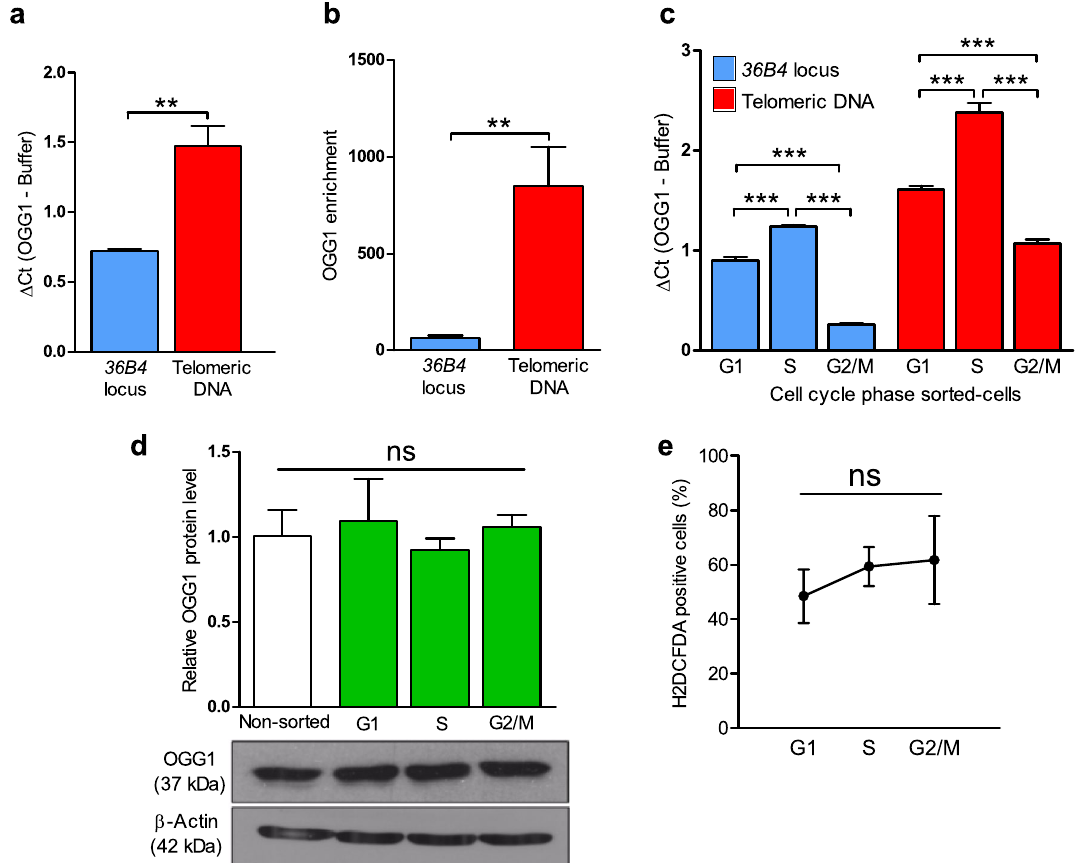
Figure 1. Telomeres are a hotspot for oxidation due to cell cycle ROS production. ( A ) DNA from U2OS cells was used to measure 8-oxoG levels at the 36B4 locus or telomeric DNA. Bars show the mean and the standard error of the mean (SEM) from 3 technical replicates from 6 independent experiments for each condition (Mann–Whitney test; **P < 0.01). ( B ) OGG1-GFP pulldown followed by chromatin immunoprecipitation coupled to PCR for amplification of either 36B4 locus or the telomere regions in the U2OS parental and U2OS OGG1-GFP cell lines. Data are the average of 3 technical replicates from 2 independent experiments. Statistical significance was determined using (Mann–Whitney test; **P < 0.01. ( C ) Sorted DNA from different cell cycle phases (G1, S, or G2/M) from U2OS cells was used to evaluate 8-oxoG levels at the 36B4 locus or telomeric DNA along the cell cycle. Bars show the mean and the SEM from 3 technical replicates from 6 independent experiments for each condition (two-sided T-test; *** P < 0.001). ( D ) Quantification of OGG1 protein expression level in U2OS cells along the cell cycle. Actin levels were used to normalize for protein loading. Immunoblotting was performed in triplicate. Statistical significance was determined by two-sided T-test (P > 0.05, ns: not significant). The full-length blots are presented in Supplementary Figure S2 ( E ) Percentage of cells with intracellular ROS levels above the median of the whole U2OS population is represented in different cell cycle stages (G1, S, or G2/M). Data are average ± SEM from single measures from 3 independent experiments. Significant differences were addressed by two-sided T-test (P > 0.05, ns: not